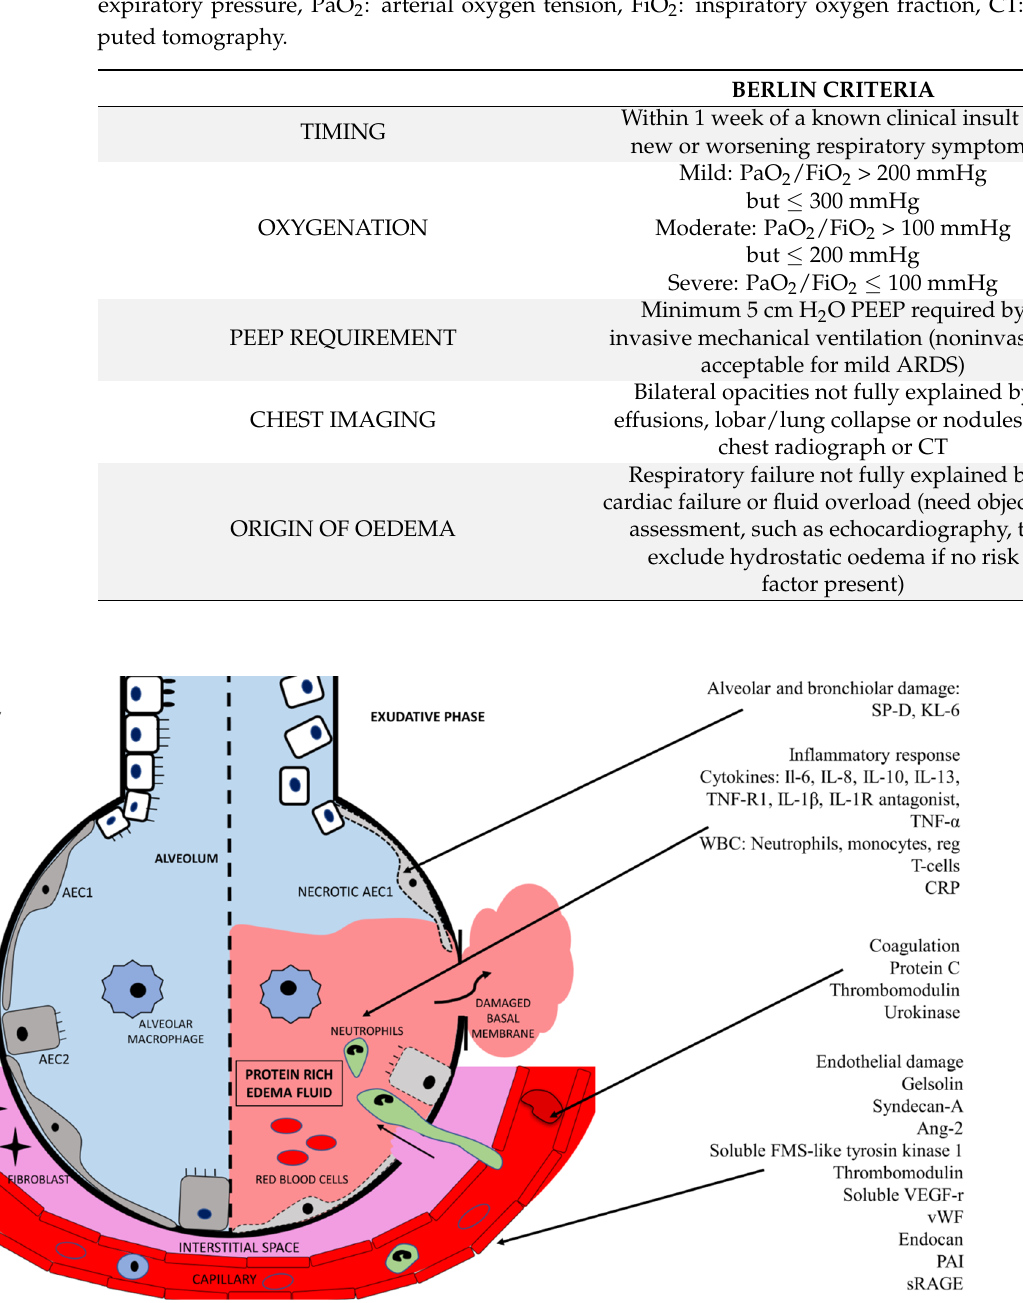
Table 1. Berlin criteria for acute respiratory distress syndrome (ARDS) [3]. PEEP: positive end-